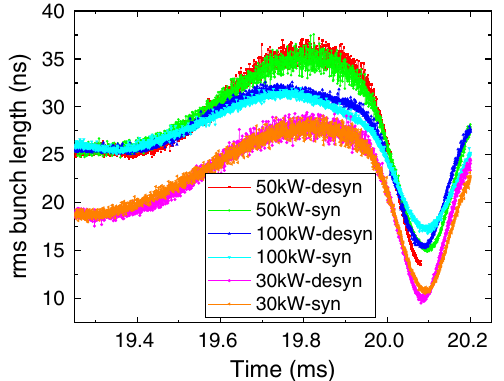
FIG. 14. Comparison between the desynchronization and synchronization on the measured bunch length under the equiv- alent beam power of 30, 50, and 100 kW. The nonadiabatic rf voltage rise time is 100 μ s for all cases. The extraction moment is 20.2 ms except 19.8 ms for the case of 50 kW with desynch-